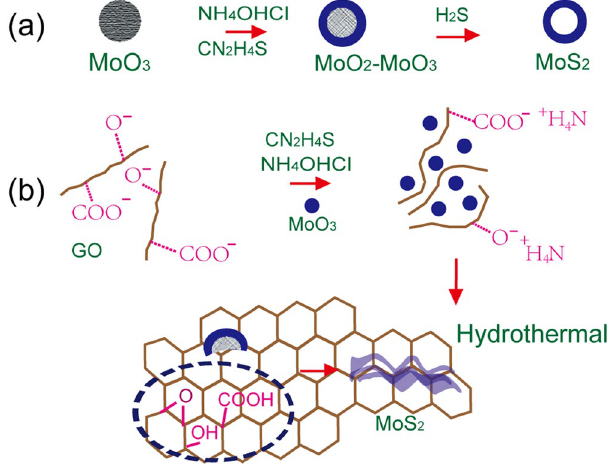
Figure 4. The synthesis of the ( a ) pristine MoS 2 and ( b ) MoS 2 @rGO composites.